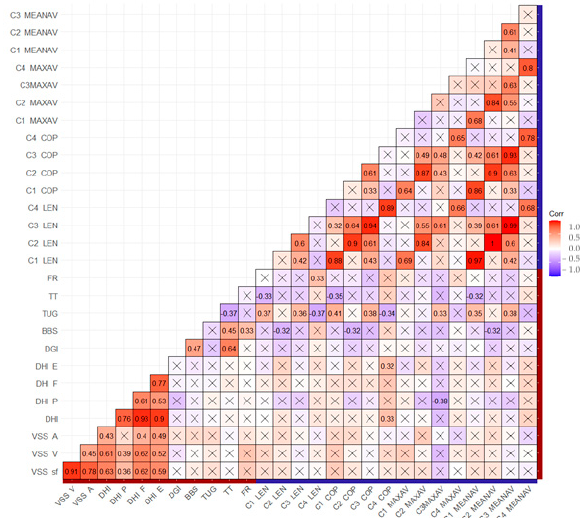
Figure 3. Correlation matrix of improvement between instrumental and non-instrumental meas- urements. The red boxes apply to Pearson’s correlation coefficient r = 1.0, and the blue boxes to r = − 1.0. A lighter color indicates a correlation close to 0 or r = 0 (white). The X-marked boxes: non-significant values. The red line in the axes: non-instrumental measures; the blue line in the axes: instrumental measures. C1—eyes open, firm surface, C2—eyes closed, firm surface, C3—eyes open, foam surface, C4—eyes closed, foam surface. LEN—length of trajectory, COP—surface of COP, MAXAV—max angular velocity, MEANAV—mean angular velocity.